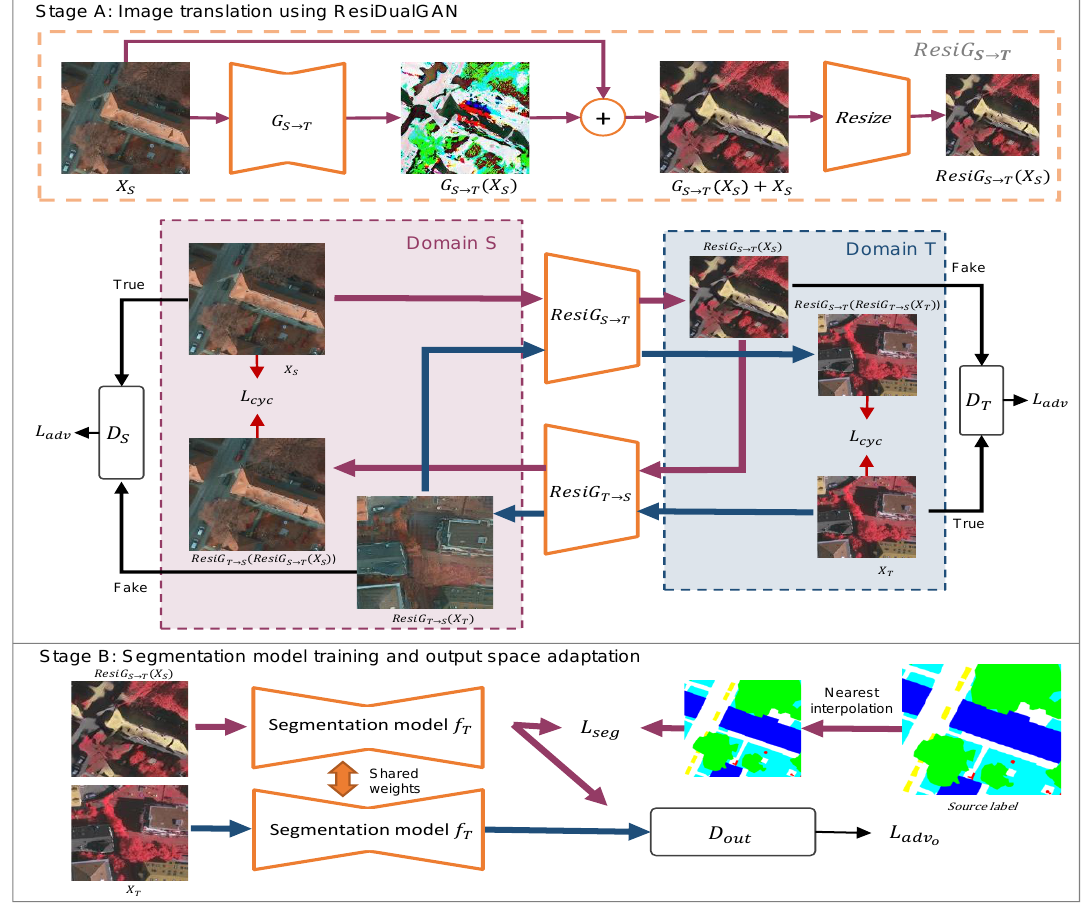
Figure 2. Overview of the proposed